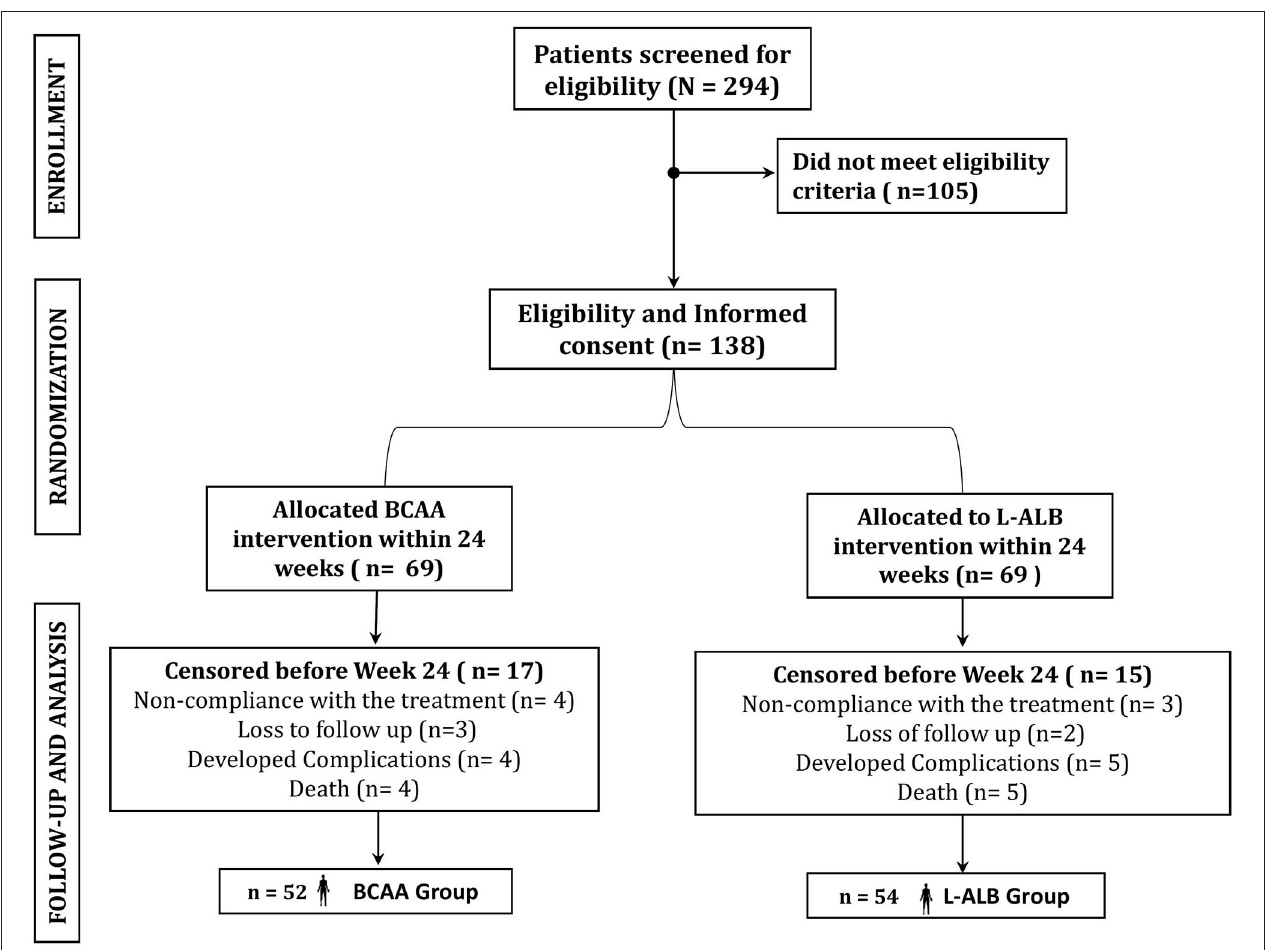
FIGURE 1 | Schematic study plan in consideration of the patients enrolled in the